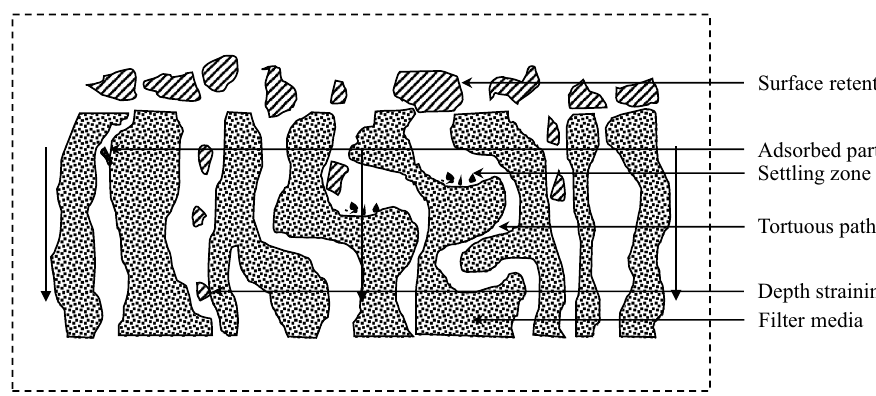
Fig. 1 Flow of fluid and parti- cles through depth filter